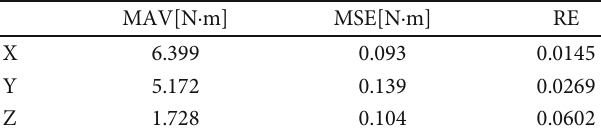
Table 1: MAV and MSE of ANN assessment. MAV[N ·